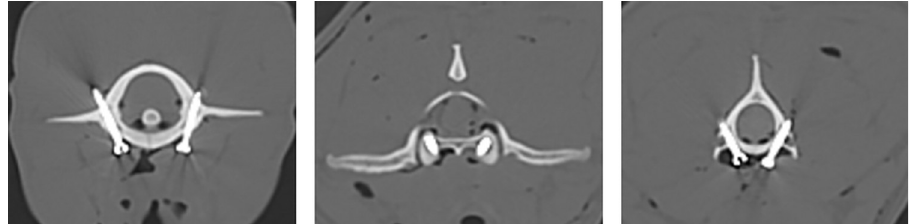
Fig 5. Transverse CT image of C1, C2 cranial, and C2 caudal.